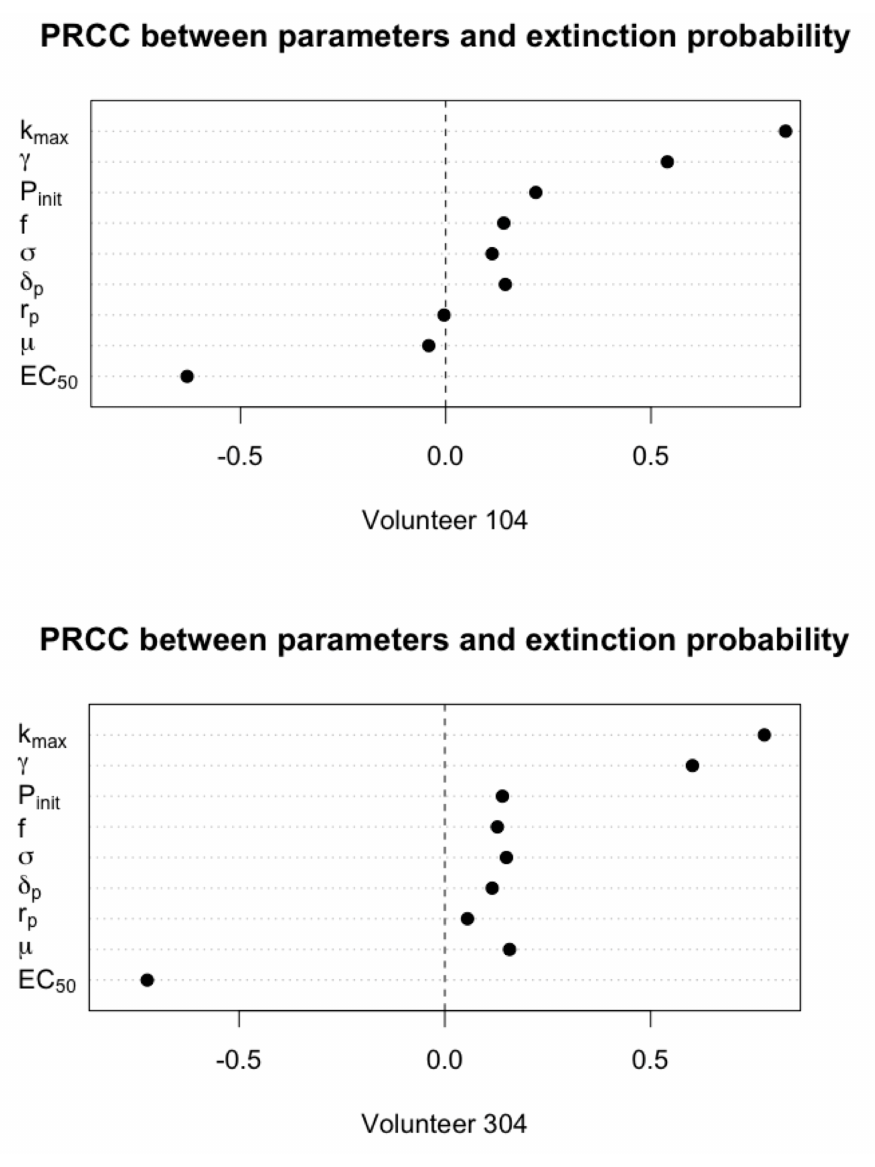
Figure 6. PRCC results for volunteer 102, 104 and 304. The top three parameters with the largest absolute values of PRCC are k max (PRCC = 0.7874), γ (PRCC = 0.5880) and EC 50 (PRCC = − 0.5245) for volunteer 102, k max (PRCC = 0.8279), EC 50 (PRCC = − 0.6299) and γ (PRCC = 0.5399) for volunteer 104 and k max (PRCC = 0.7764), EC 50 (PRCC = − 0.7232), γ (PRCC = 0.6017) for volunteer